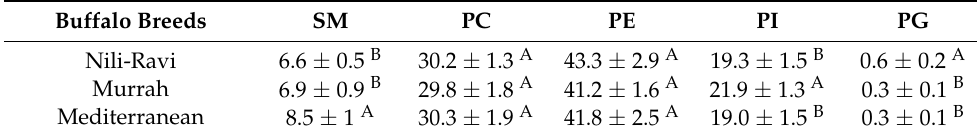
Table 3. Polar lipid composition of milk from different breeds (% of polar lipids). Buffalo Breeds SM PC PE PI PG Nili-Ravi Mediterranean 0.3 ± 0.1